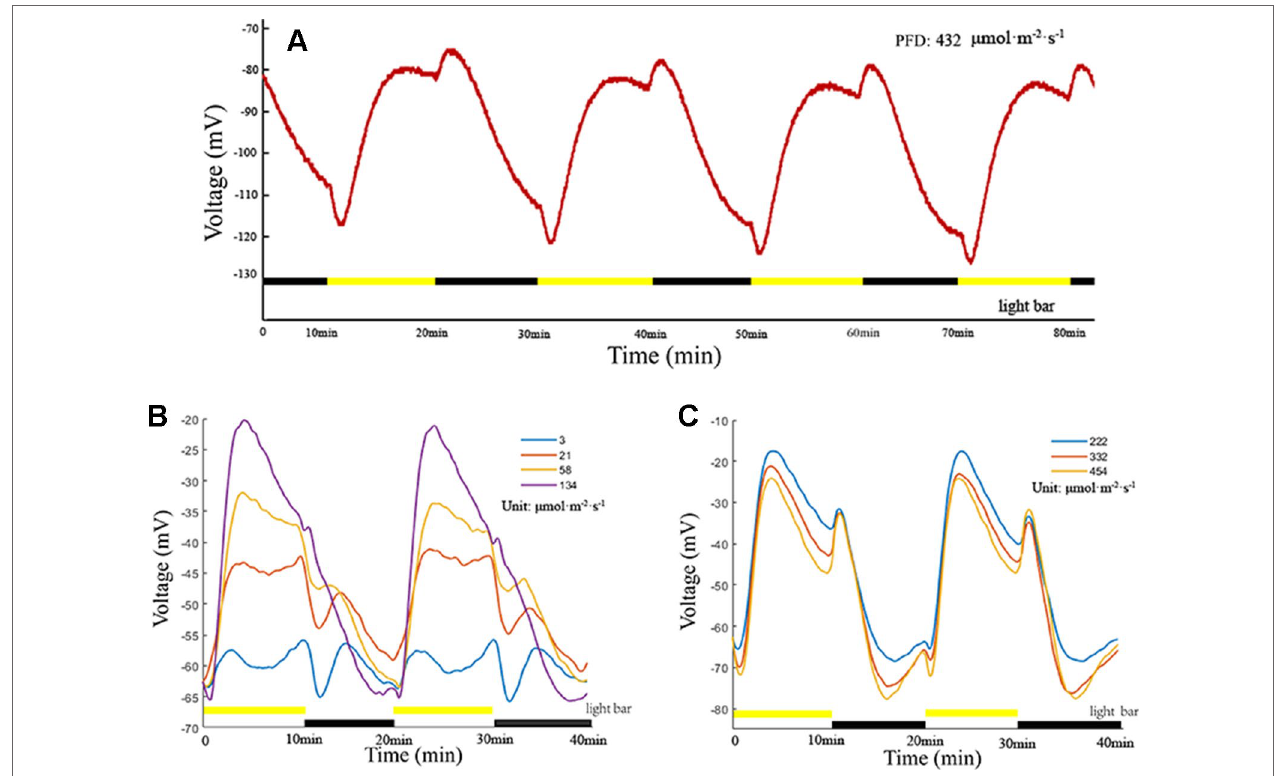
FIgURe 3 | Light-induced bioelectrogenesis (LIB). (a) A highly reproducible LIB under periodic illumination/darkness. The yellow bars indicate the illumination periods and the black bars indicate the darkness periods. (B , C) LIB of different amplitudes under different light intensities. Yellow bars and black bars are not in the same line, indicating that the light intensity was